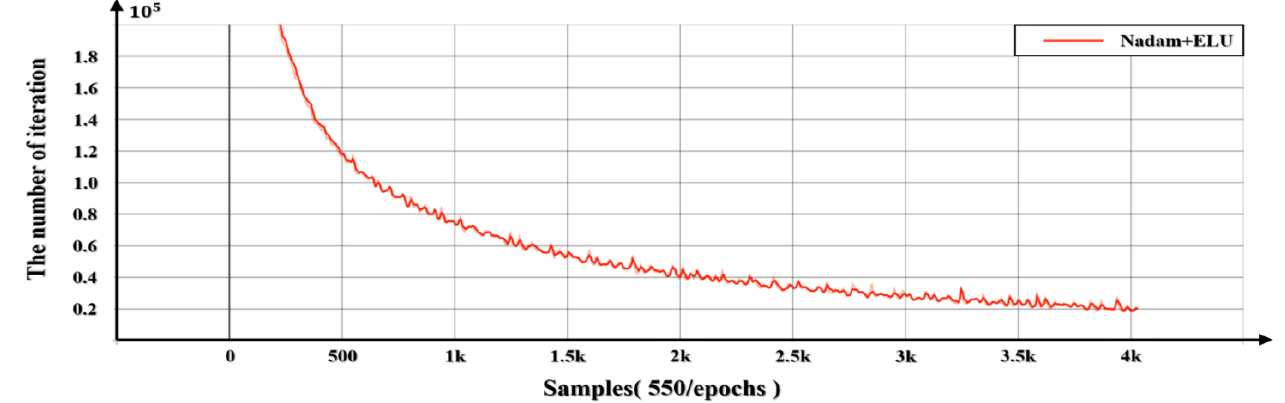
Figure 14. The loss function for the solution of Nadam+ELU.